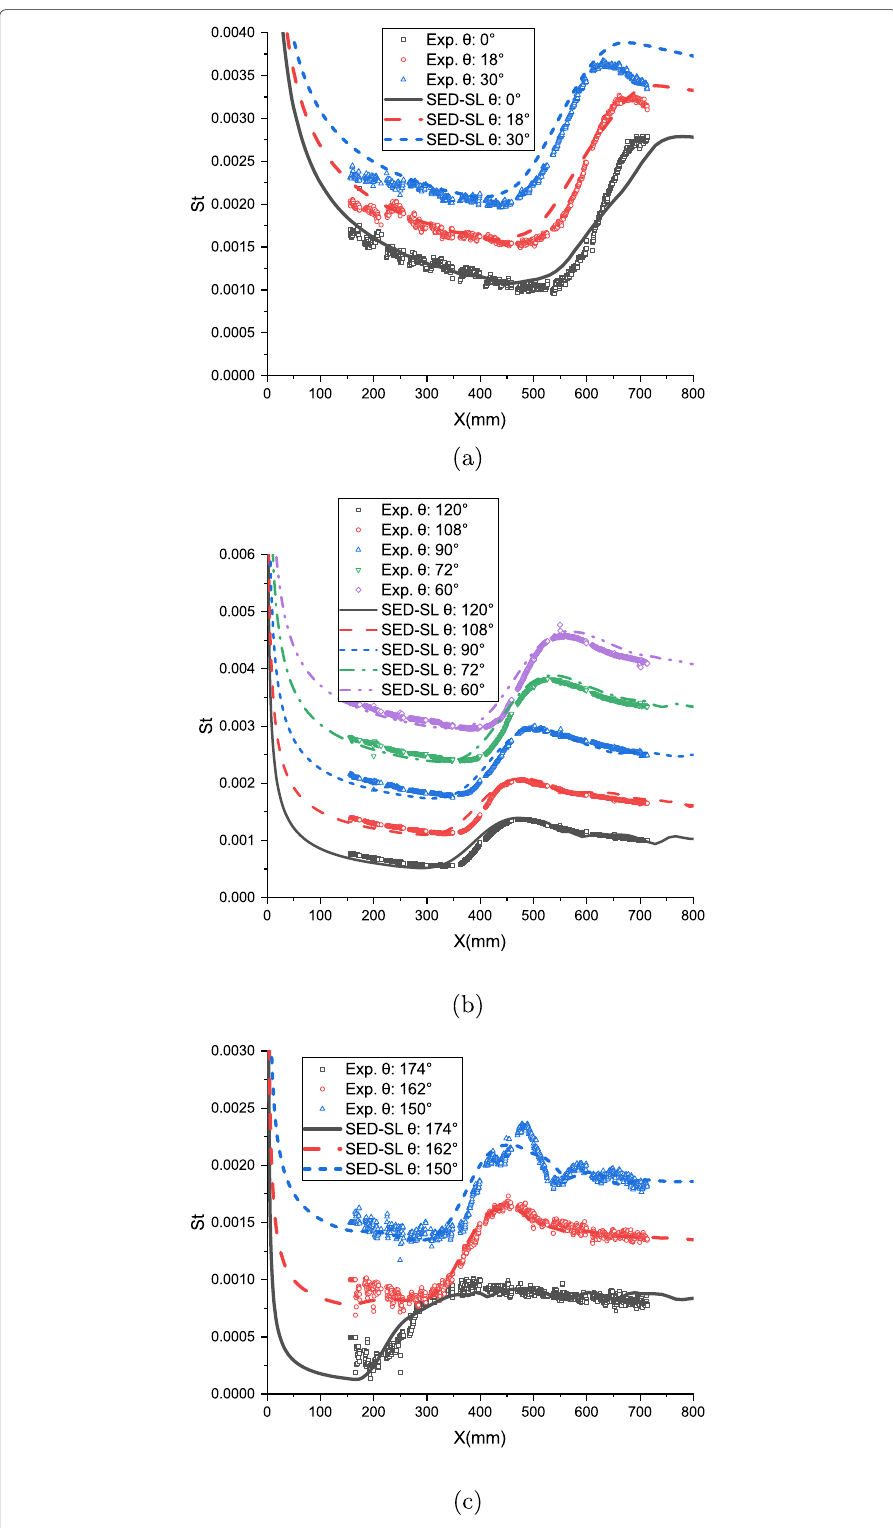
Fig. 4 Comparisons between the St distributions along the meridian lines measured in experiment [22] and computed by the SED-SL model for a the windward surface, b the lateral surface, and c the leeward surface of the GAC-6 case. The data are vertically translated to be clearly